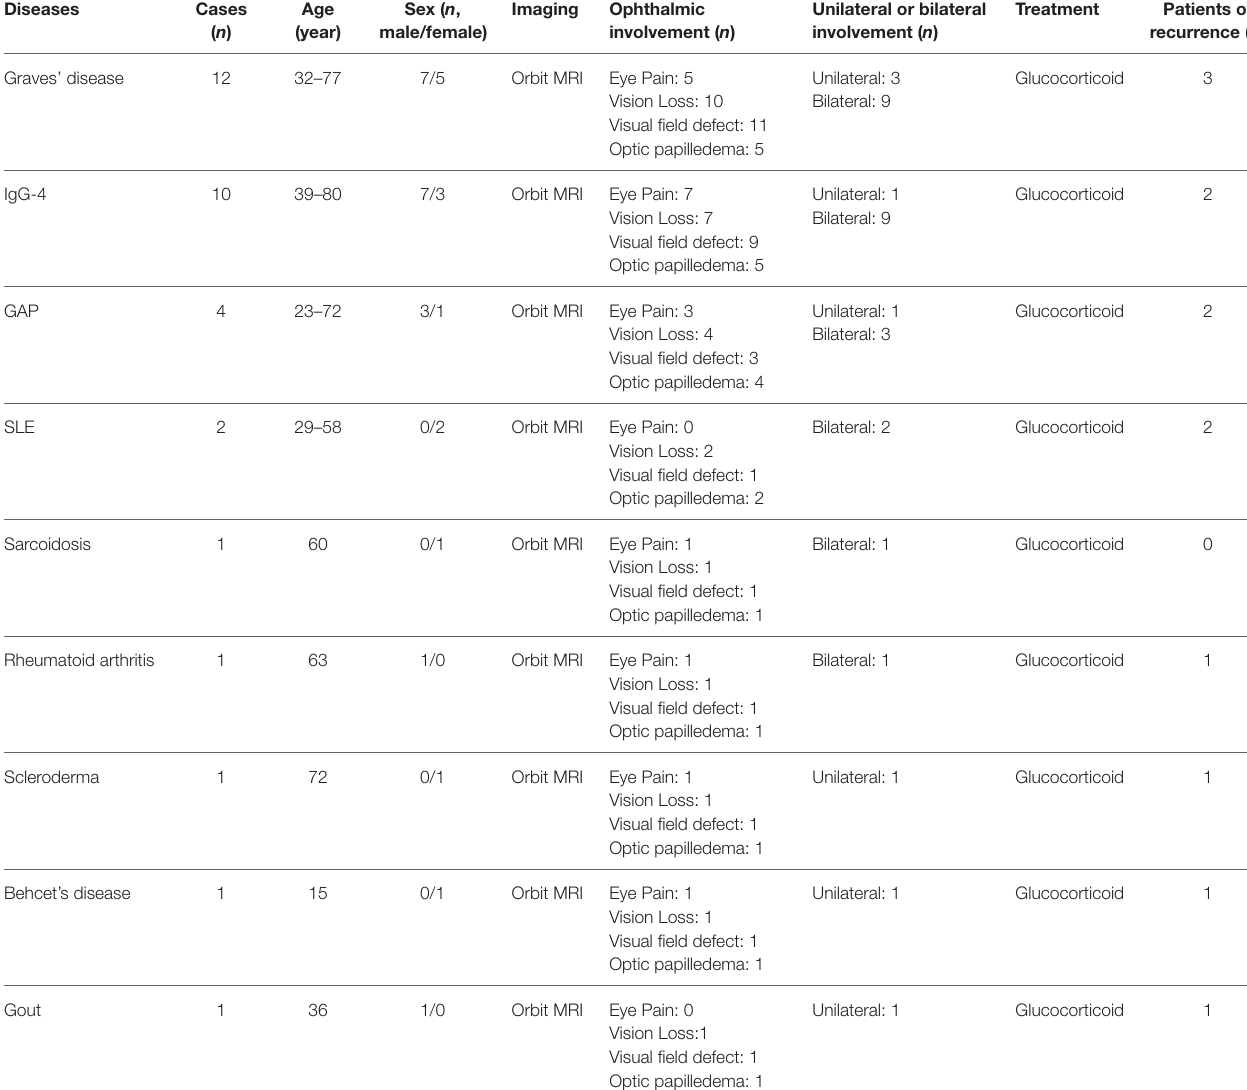
TABLE 3 | Neuro-ophthalmic findings of OPNs with autoimmune diseases. Diseases